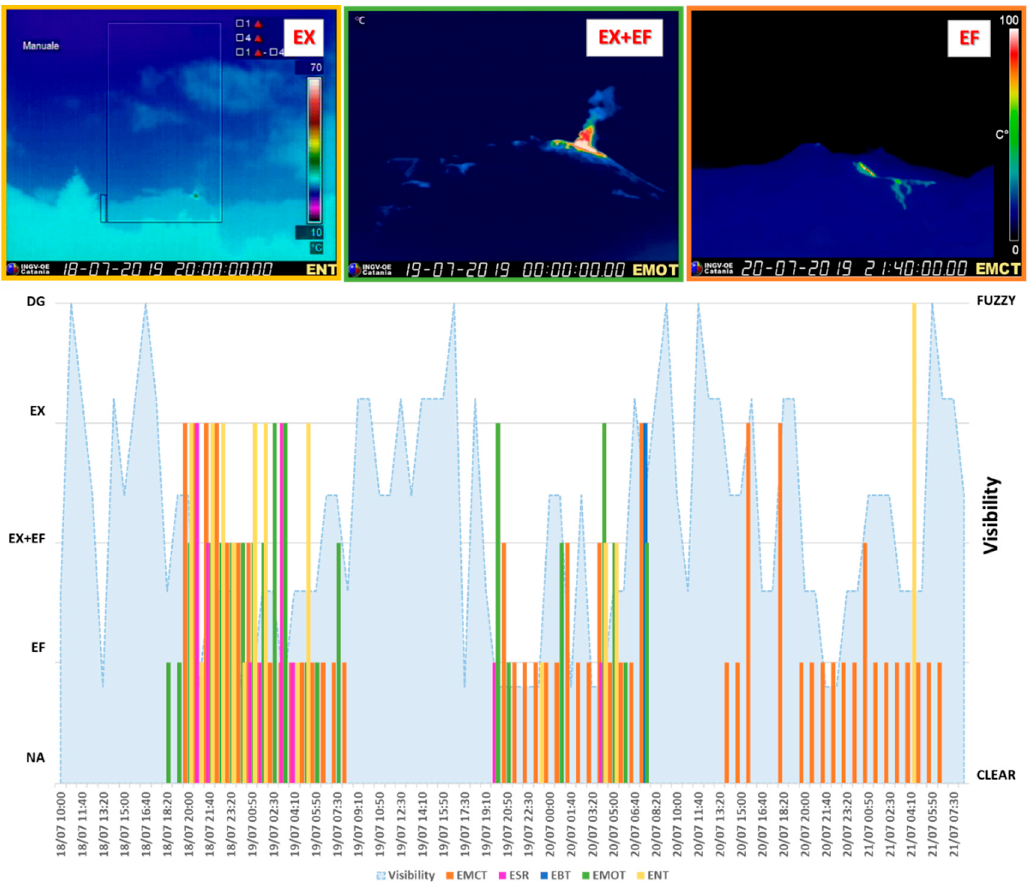
Figure 5. Volcanic activity evolution detected by the ML algorithm from the 18th to the 21st July, 2019. “DG”, “EX”, “EX+EF”, “EF” and “NA” stand for degassing, explosive, explosive and effusive, effusive and no activity respectively. The visibility index is given by the average of the visibility indexes for all the cameras.